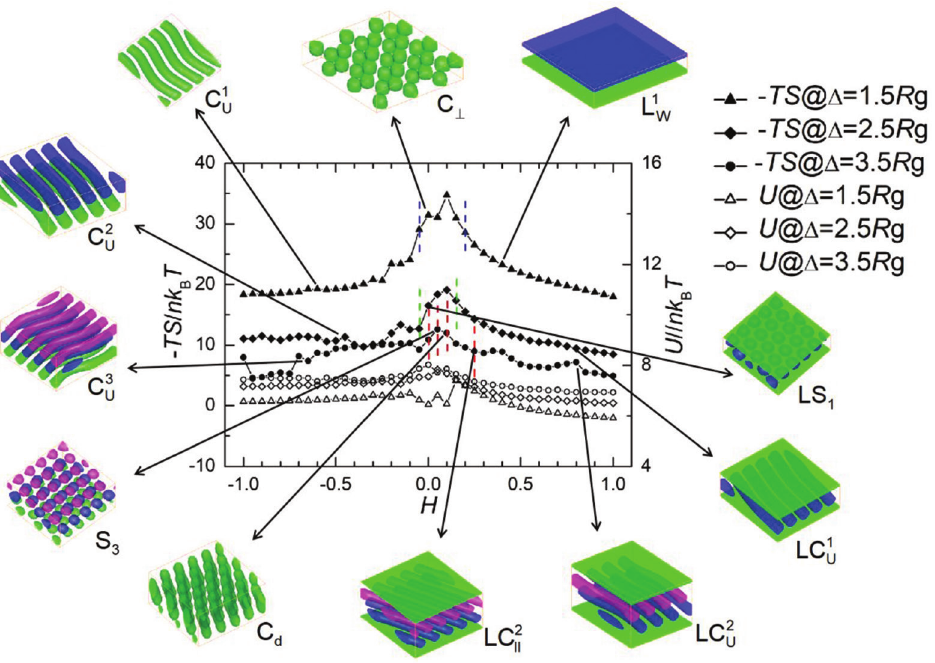
Figure 14: Free energy variation and the according morphology stability regions of confined thin film of dendrimer copolymer as a function of the surface field strength ( H ) with χ